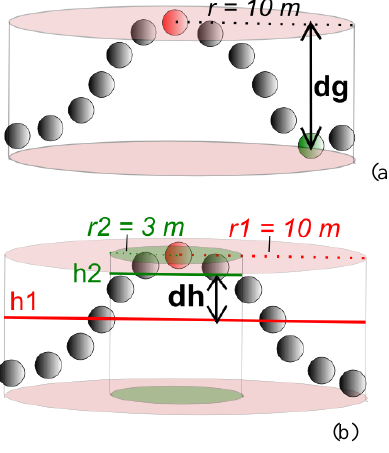
Figure 3: Sketch of the features distance to ground dg (a) and difference of average heights dh (b) in a laser point profile